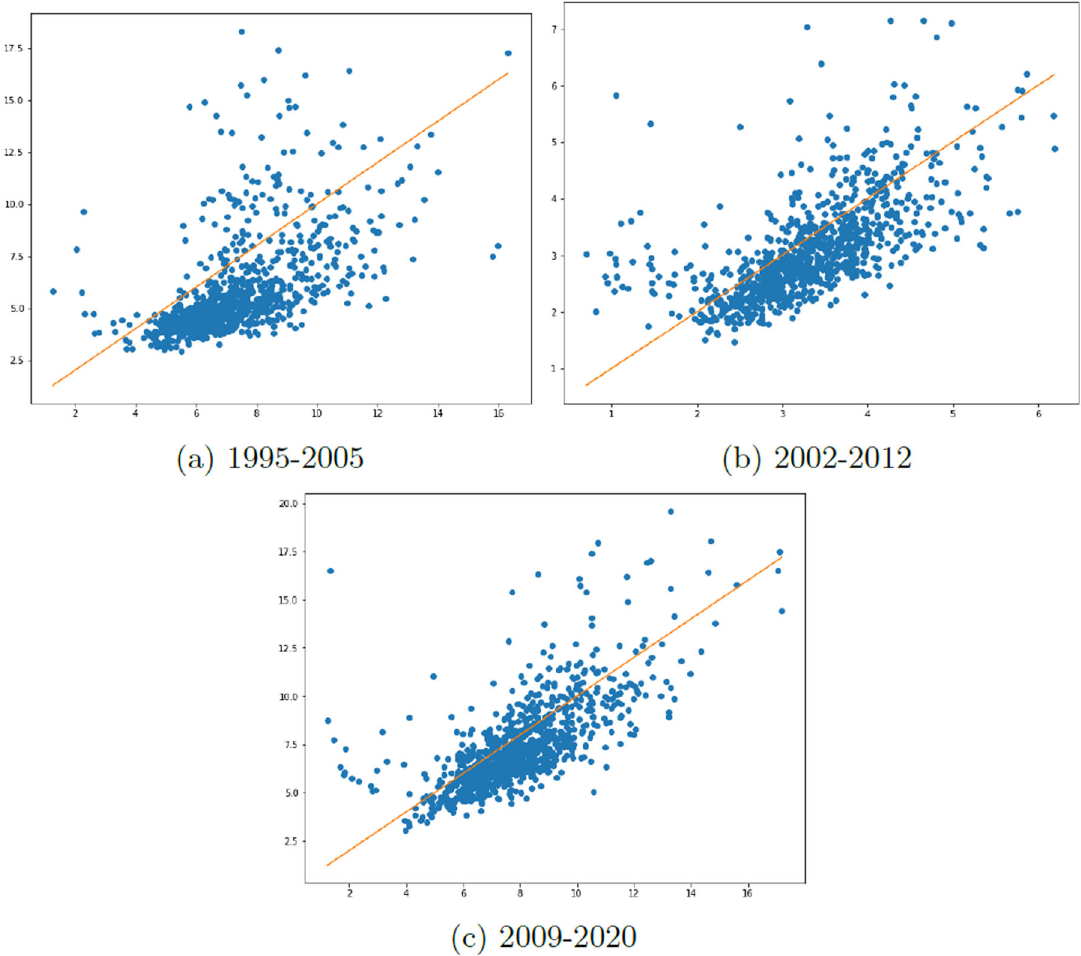
Fig. 4 End value of one dollar after 10 years for multiple samples. The fi rst coordinate is the constrained portfolio, while the second coordinate is the unconstrained